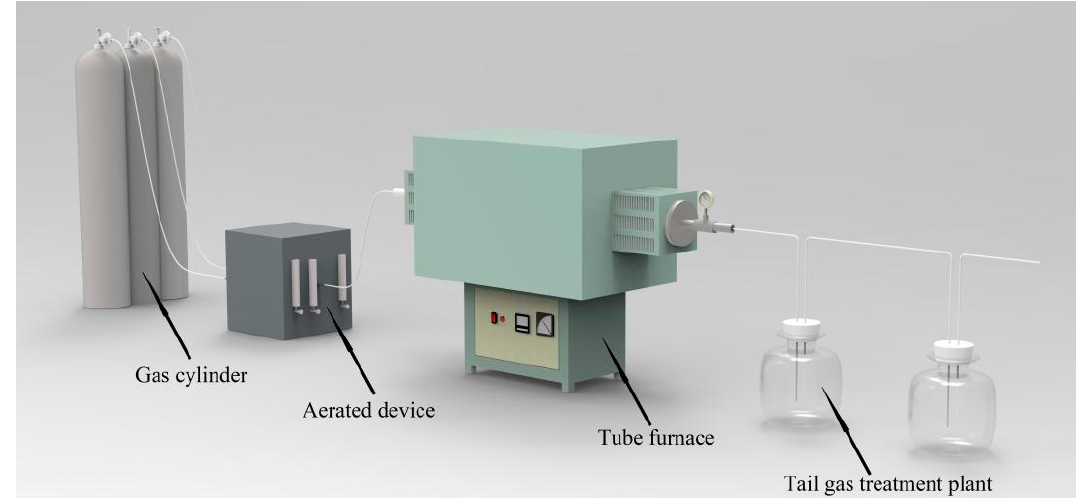
Figure 8. Schematic diagram of heat treatment under simulated working conditions.